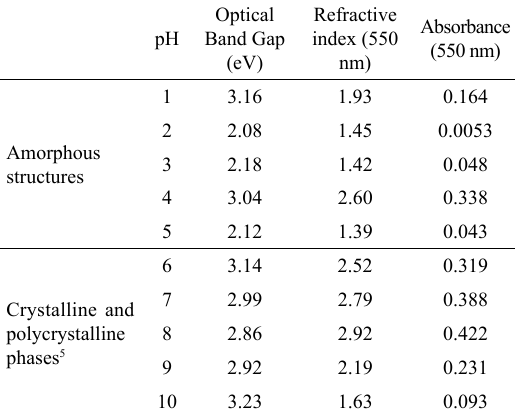
Table 1. Compare of the some optical properties of the amorphous and crystalline thin films. Optical pH Band Gap (eV)